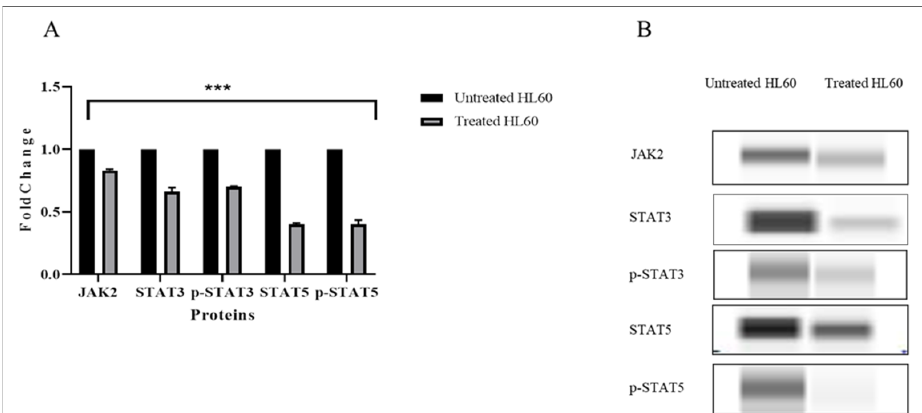
Figure 8. Effects of TQ on the expression of JAK/STAT proteins in HL60 cells. ( A ) JAK2, STAT3, p-STAT3, STAT5, and p-STAT5 protein expression in TQ-treated cells compared with untreated cells or negative control. Data are presented as the mean ± SEM ( *** p < 0.001). ( B ) Images of JAK2, STAT3, p-STAT3, STAT5, and p-STAT5 protein expression from capillary Western blotting in treated and untreated HL60 cells.